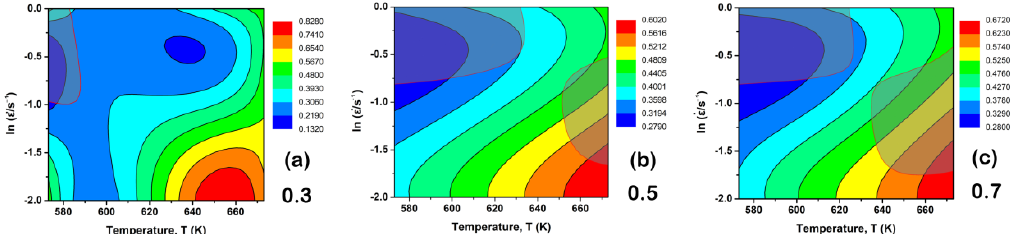
Figure 12. Hot processing maps at different strains: ( a ) 0.3; ( b ) 0.5; ( c ) 0.7.